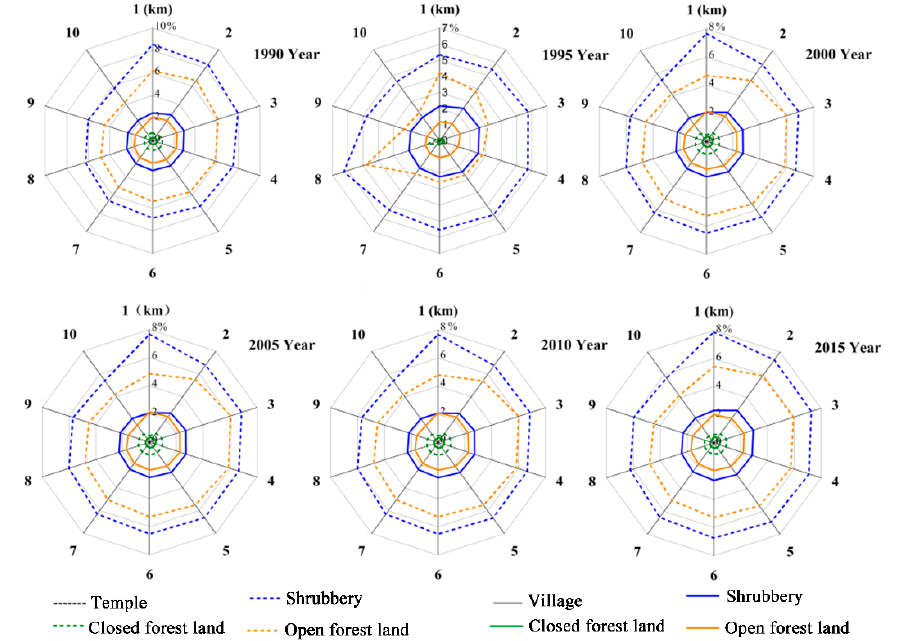
Figure 4. The percentage of three types of forest around the temples and villages from 1990 to 2015.